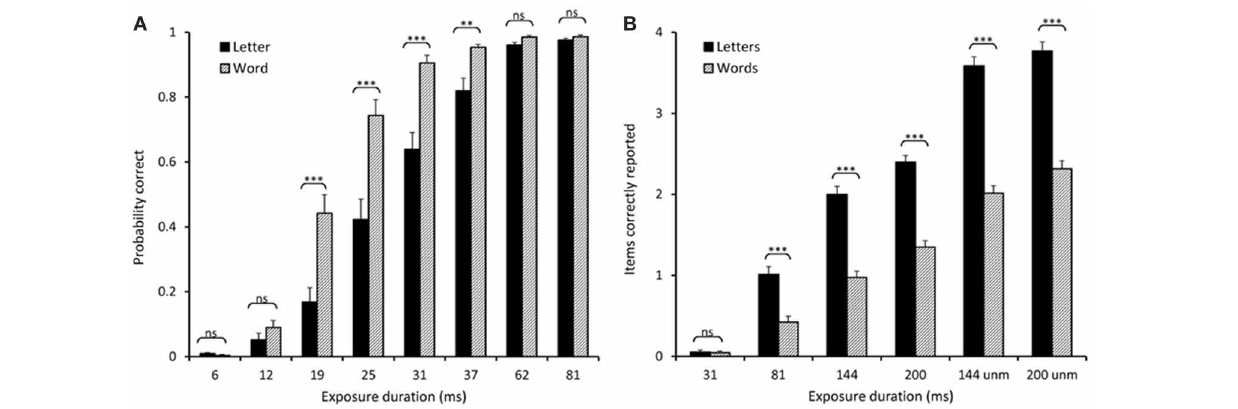
FIGURE 2 | Comparison of raw scores. (A) Experiment 2: Proportion correct for letters and words at the different exposure durations. (B) Experiment 3: Number of items correctly reported for words/letters at the different exposure durations. ∗∗ p < 0 . 01, ∗∗∗ p < 0 . 001.